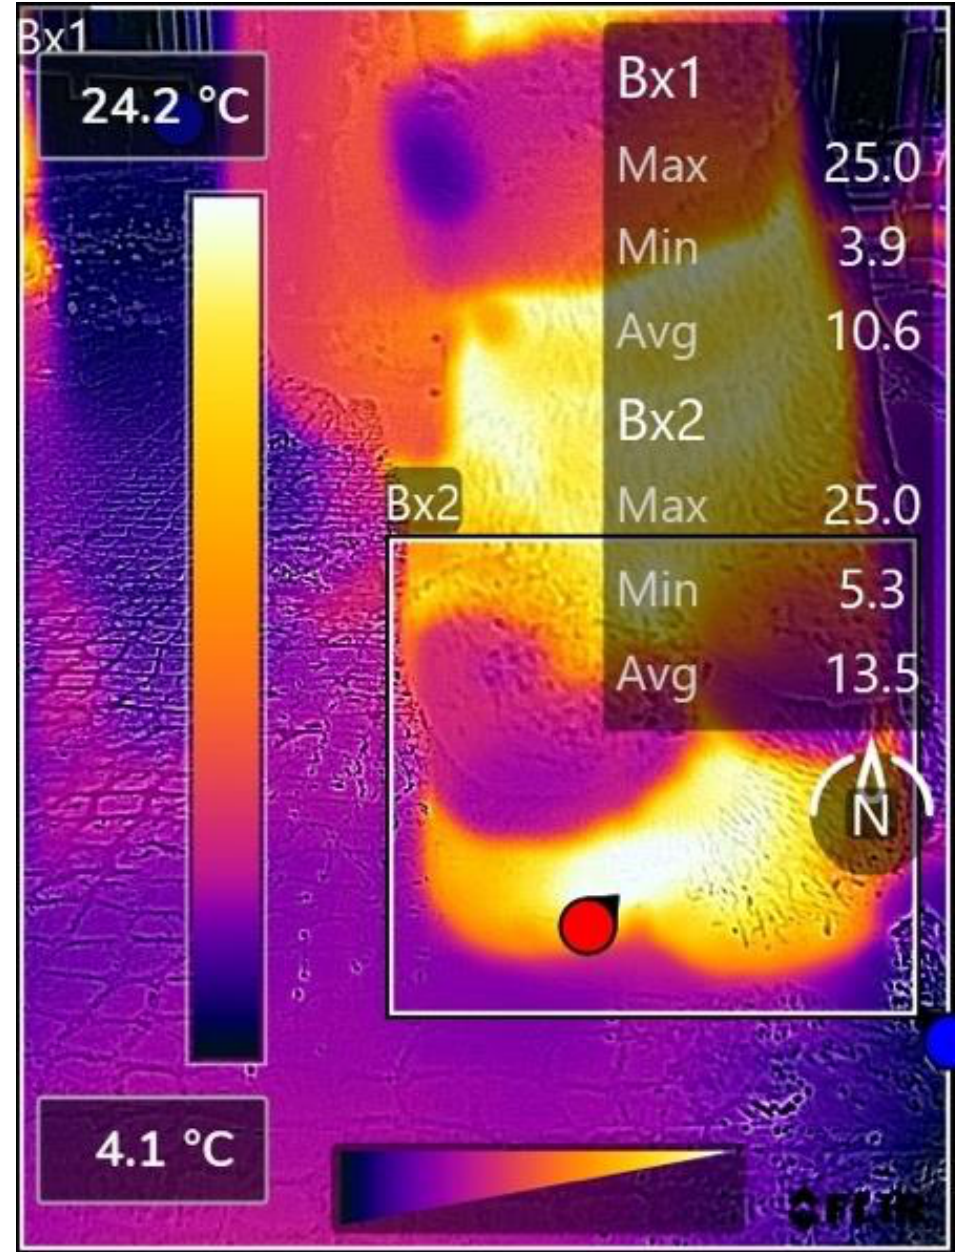
Figure A2. A thermogram, obtained by the CAT s62-Pro Smartphone (LCD), of cattle diagnosed with digital dermatitis on routine foot trimming, displaying a pattern of heat with maximum intensity over the interdigital space, rather than between the heel bulbs.